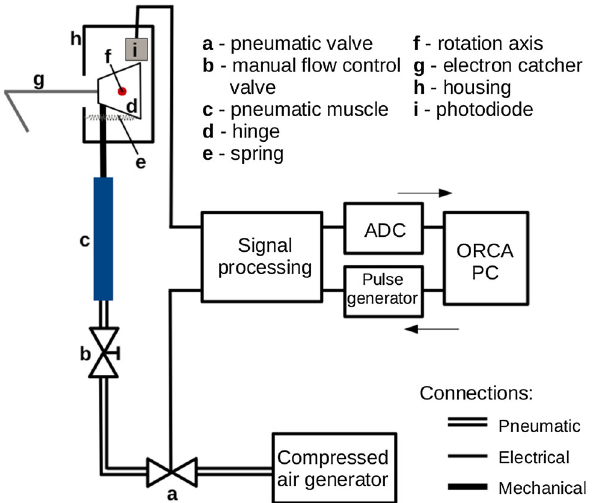
Fig. 7 Schematic diagram of the electron catcher operation. The arrows show the direction of the data flow. To remove the catcher from the flux tube: (1) the pulse generator is first activated by ORCA and creates a TTL signal, (2) the signal proceeds to the signal processing stage and is transformed to a 24-V signal which closes the pneumatic valve (a) to the compressed air supply, (3) the pneumatic muscle (c), which is connected to the hinge (d) held by the spring (e), is relaxed. Whenthesignaldropslow,thevalvereopens,causingthecontractionof the muscle which then pulls the hinge and rotates it around the axis (f), thereby moving the electron catcher (g) back to the flux tube. The speed of the muscle contraction and consequently of the catcher’s movement can be regulated by the manual flow control valve (b). In this config- uration, infrared light from an LED installed inside the photoelectric housing (h) is reflected from the hinge onto the photodiode (i). The photodiode signal enters the signal processing stage and is converted to a TTL signal. The signal increase (or decrease for the case in which the Fig. 8 a View of the catchers installed in the valve between the spec-